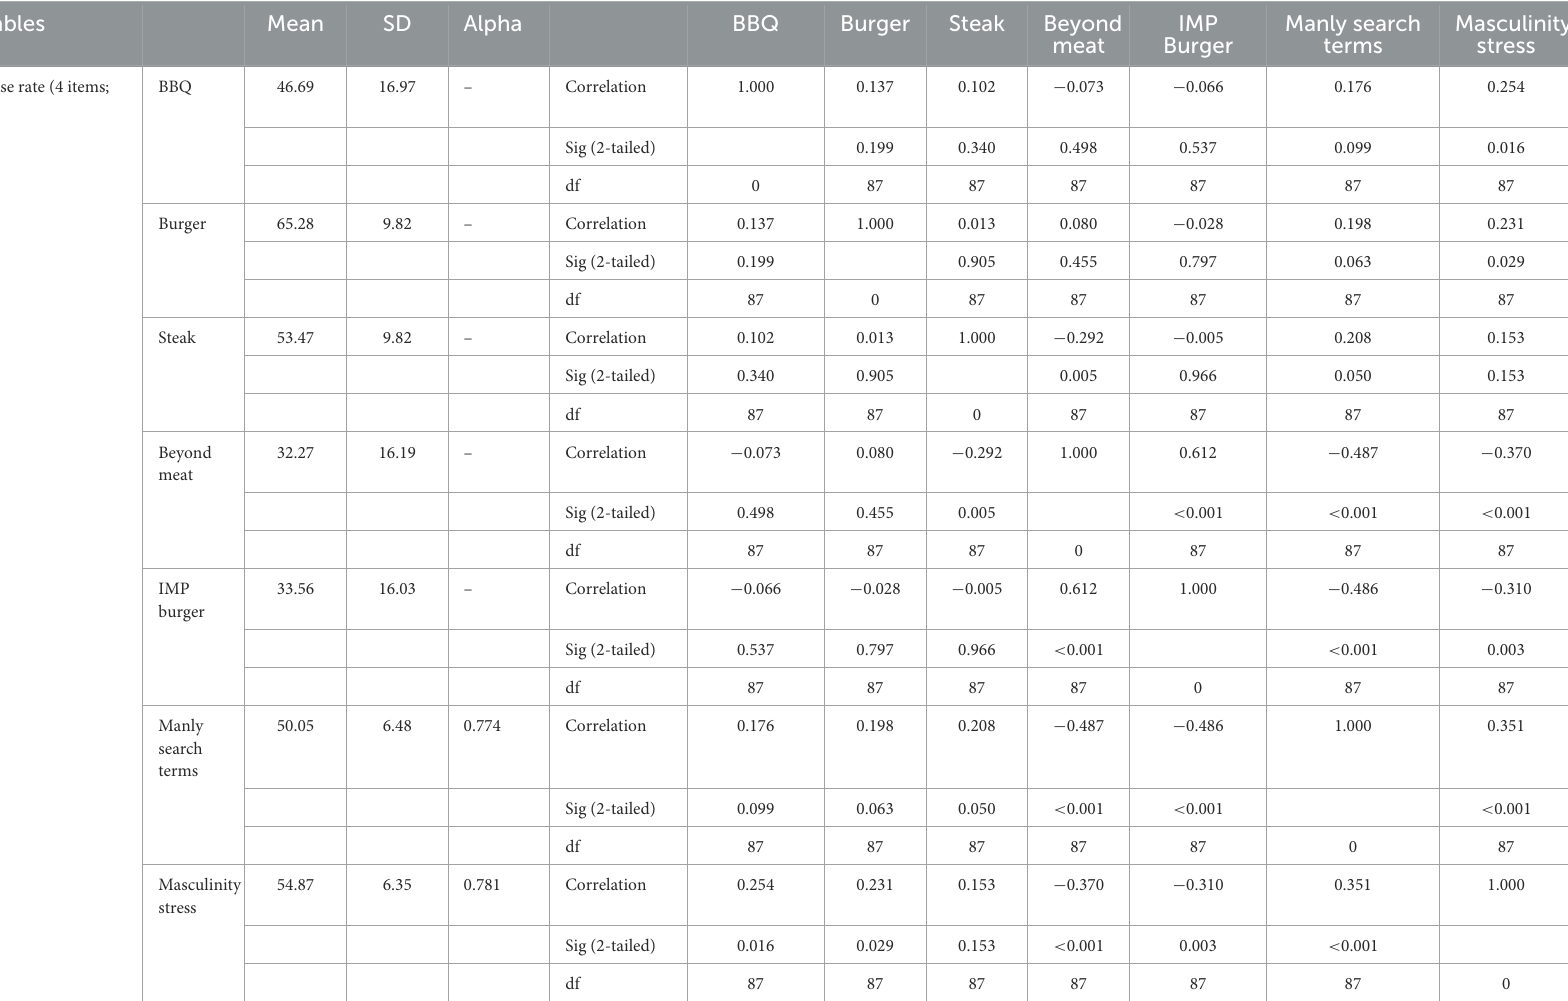
TABLE 1 Study 1 correlations and descriptives. Control